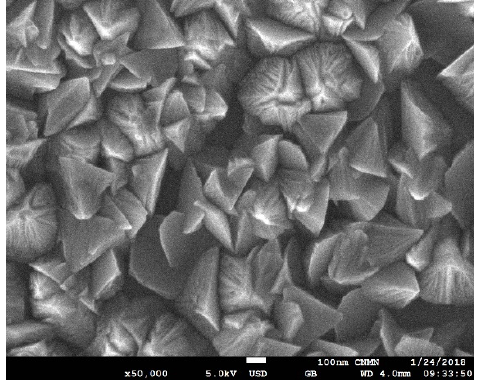
Figure 3. Typical SEM micrograph of the ZnO thin solid film.